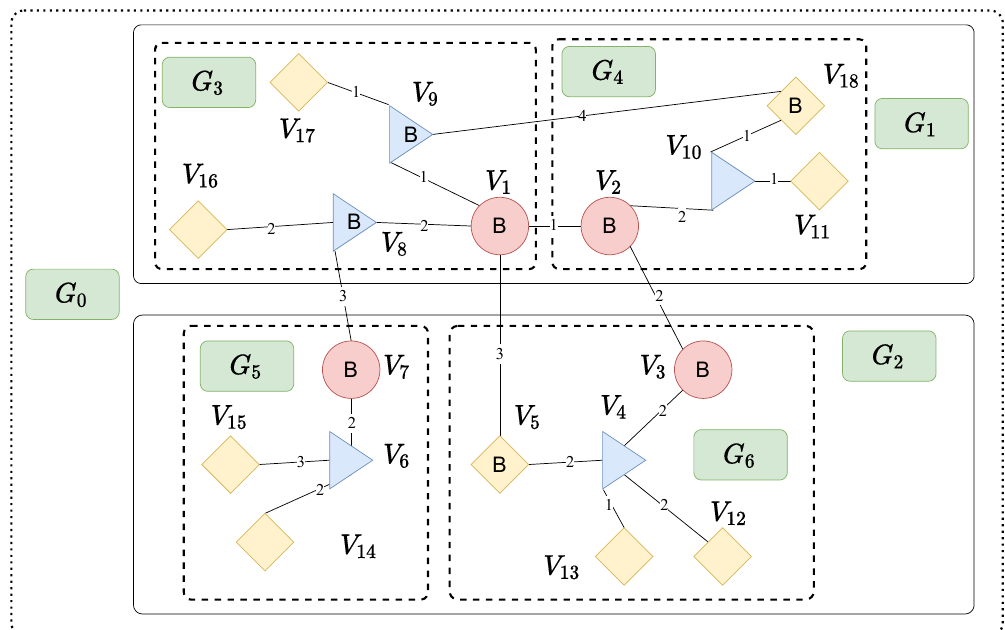
Figure 3. An example of the BVCP graph. Cloud nodes are marked in pink, fog nodes are marked in blue and edge nodes are marked in yellow.